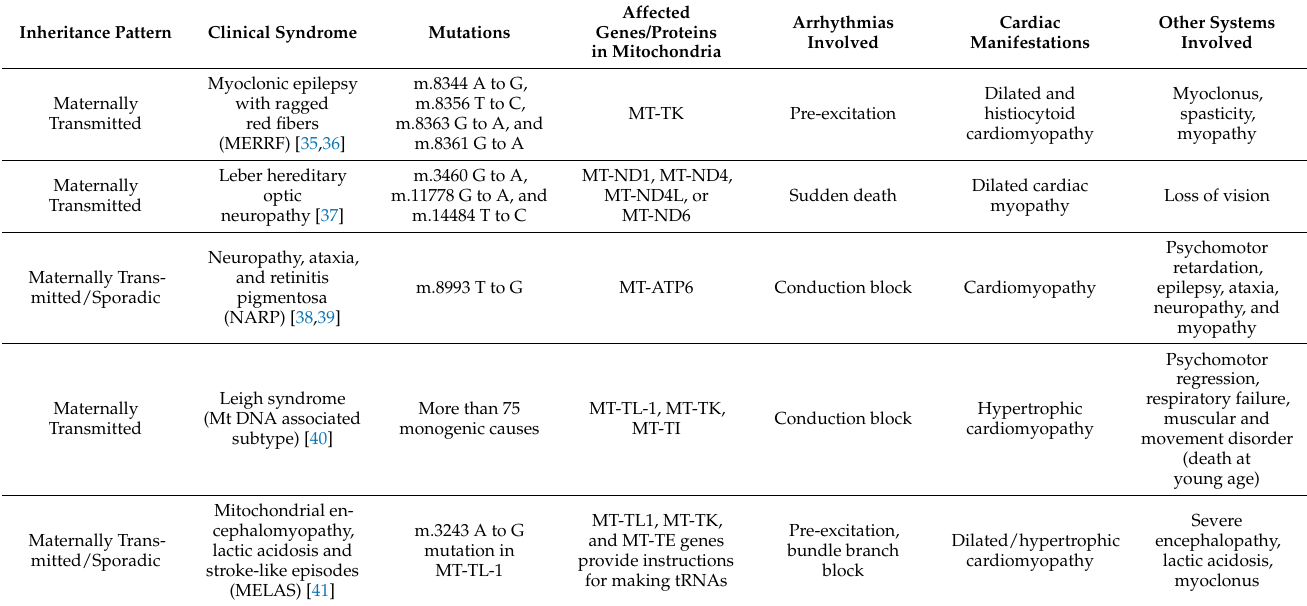
Table 1. Summary of inherited mitochondrial dysfunction